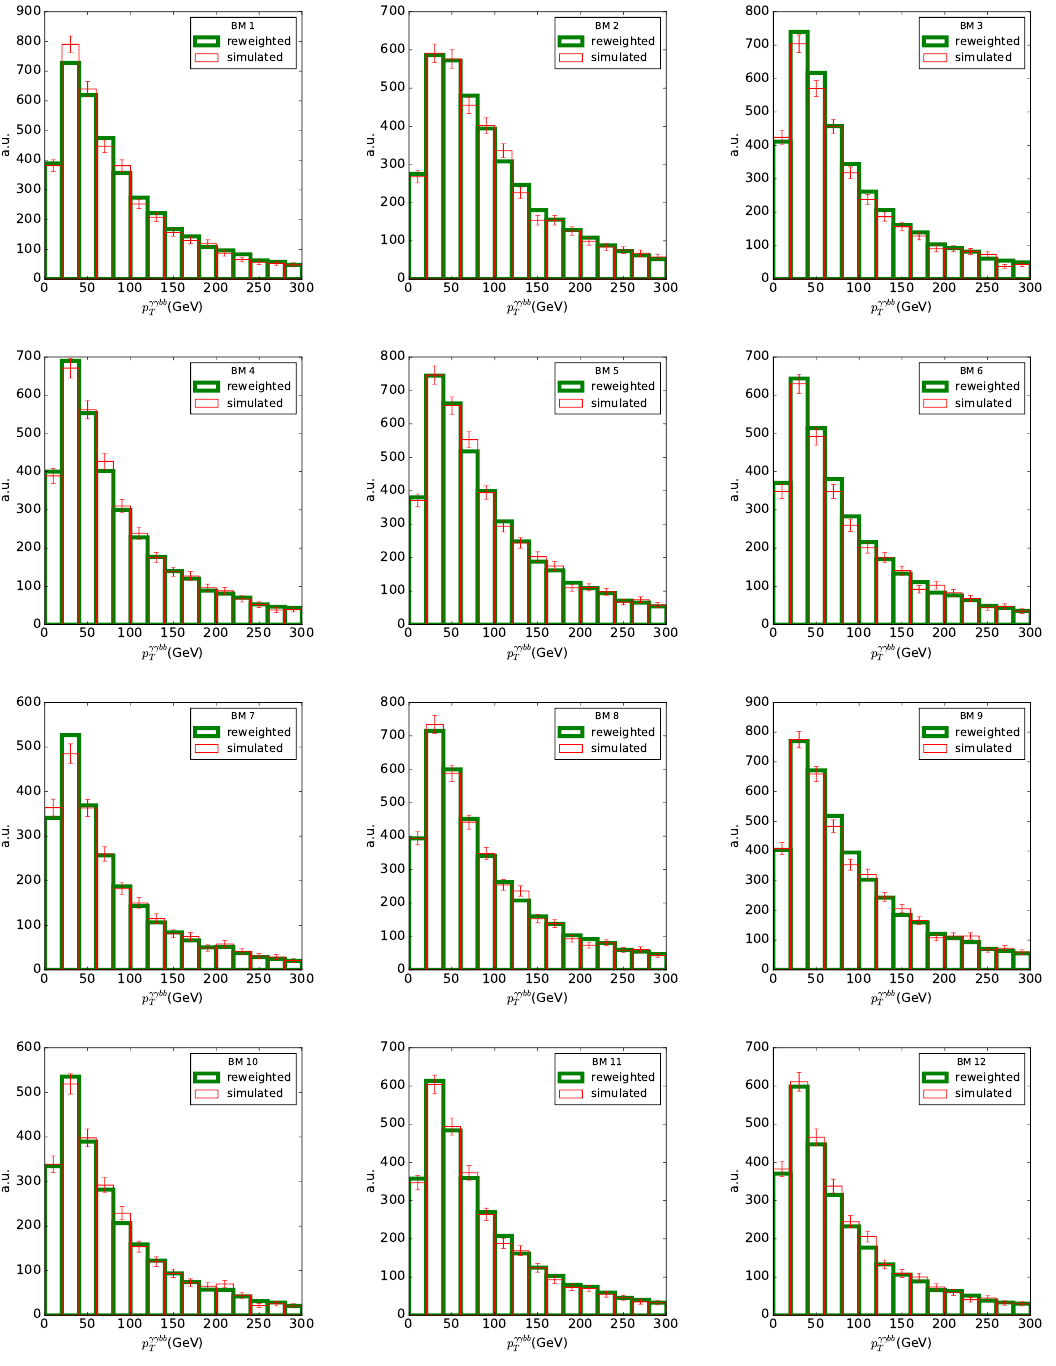
¯ b after ATLAS-like selection. The histograms are normalized T